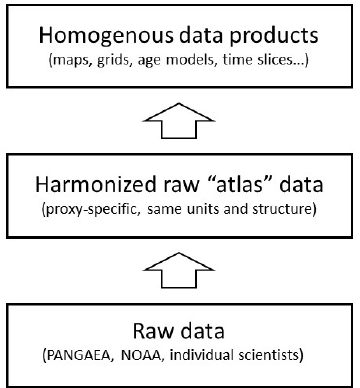
Figure 11. Potential workflow to form sustainable data products from raw